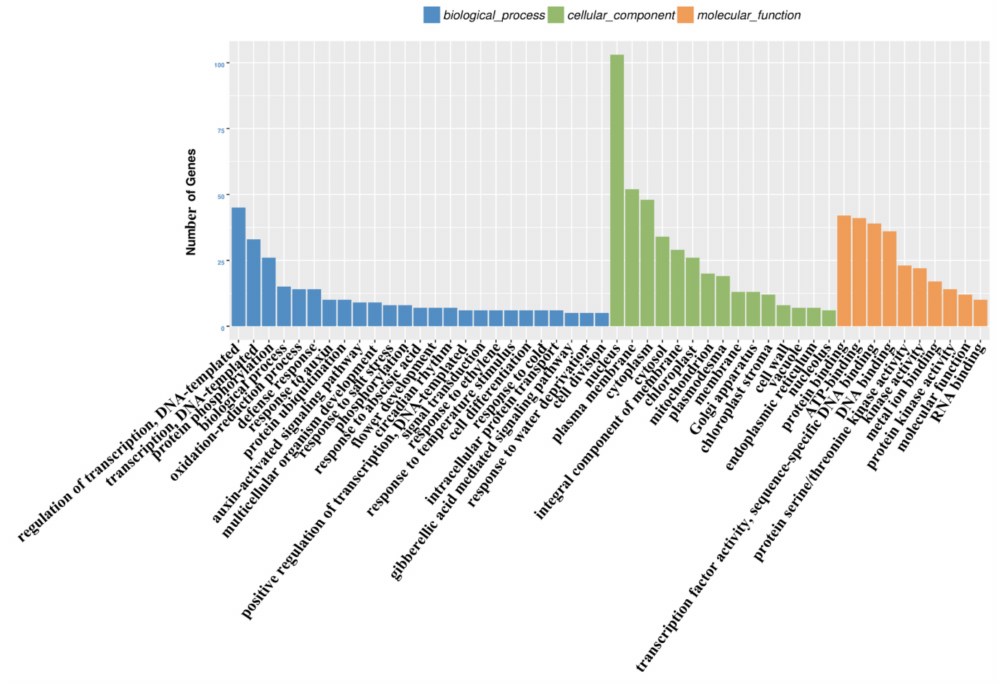
Figure 5. Gene Ontology functional classification of identified target genes.